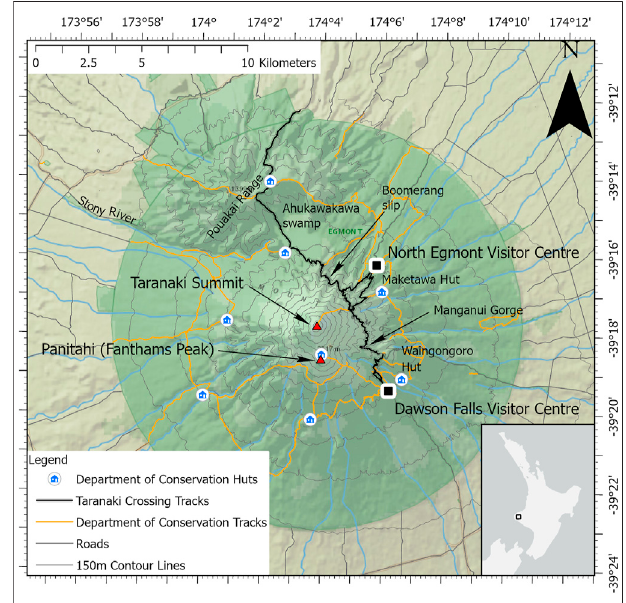
FIGURE1| DepartmentofConservationtracksandhutsinTePapakura o Taranaki, highlighting key locations in this hazard